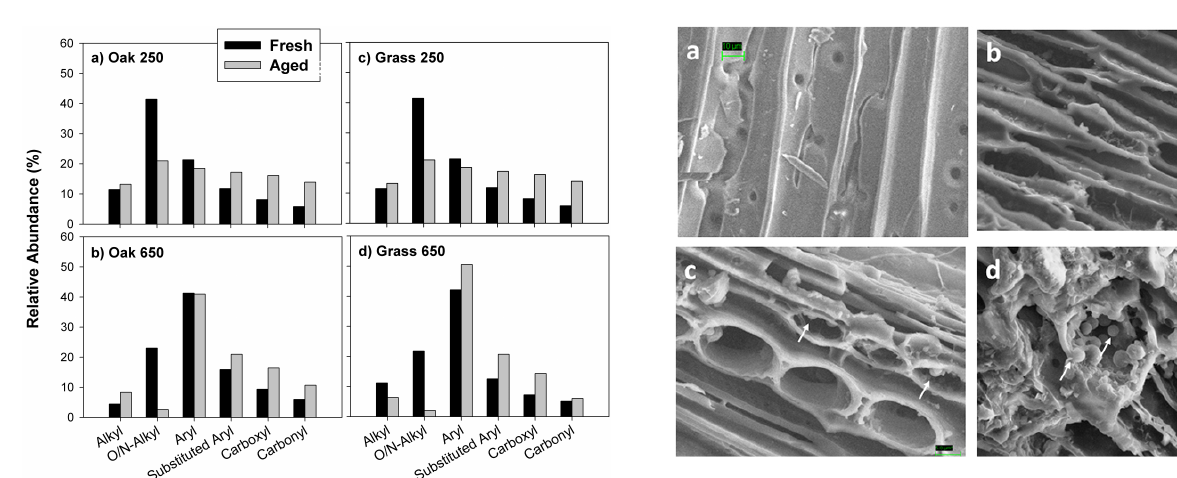
Figure 4. Representative scanning electron micrographs of fresh oak-250 and oak-650 biochar ( a and b , respectively), and oak-650 biochar field-aged alone (c) and with soil (d) . Scale bars = 10µm (a) and 5µm (b–d) . Putative occoid microbes are indicated with